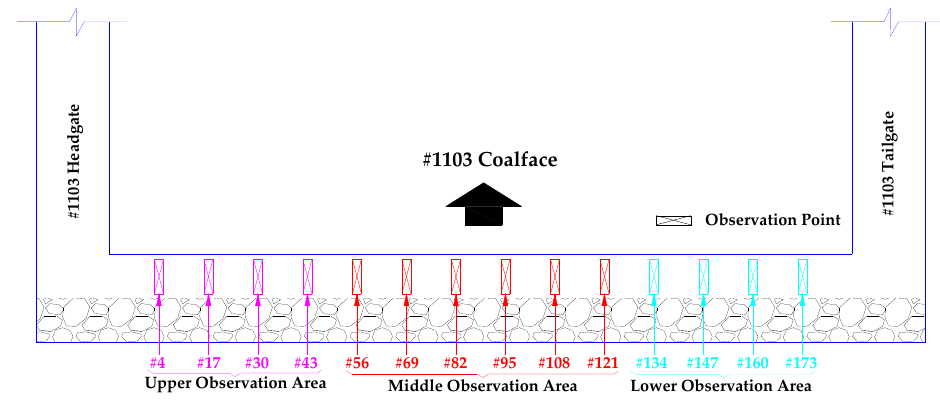
Figure 8. Layout of underground observation points.